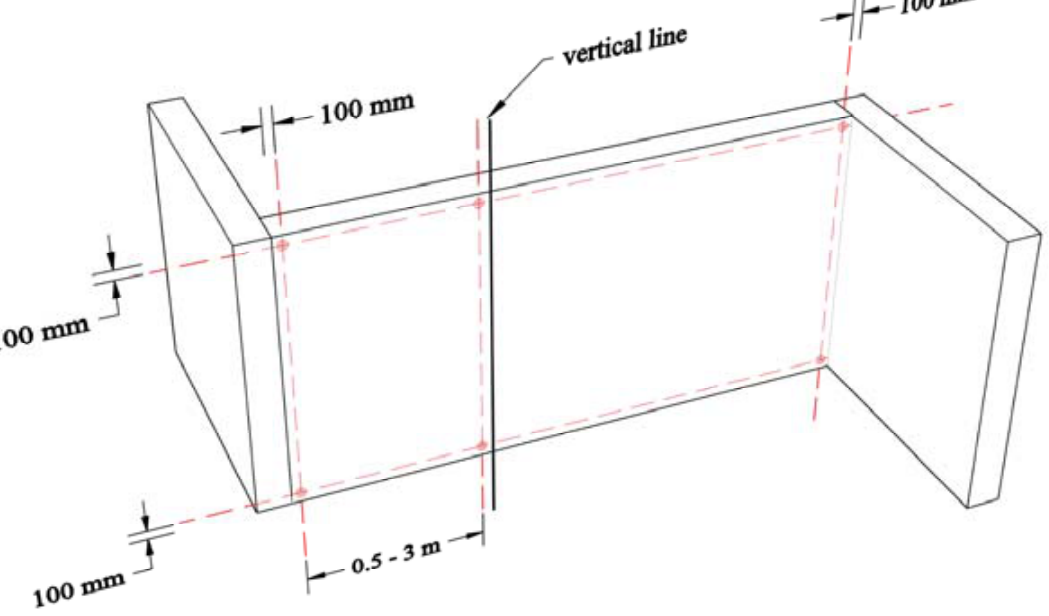
Figure 1. An example of verification of position and verticality of a wall.